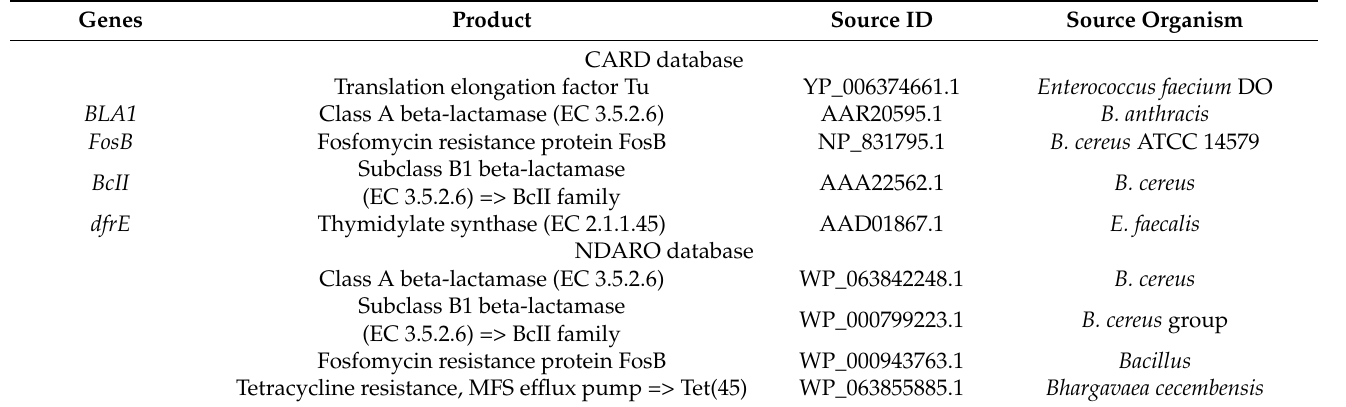
Table 3. AMR genes prediction of Bacillus sp. B87 based on NDARO and CARD